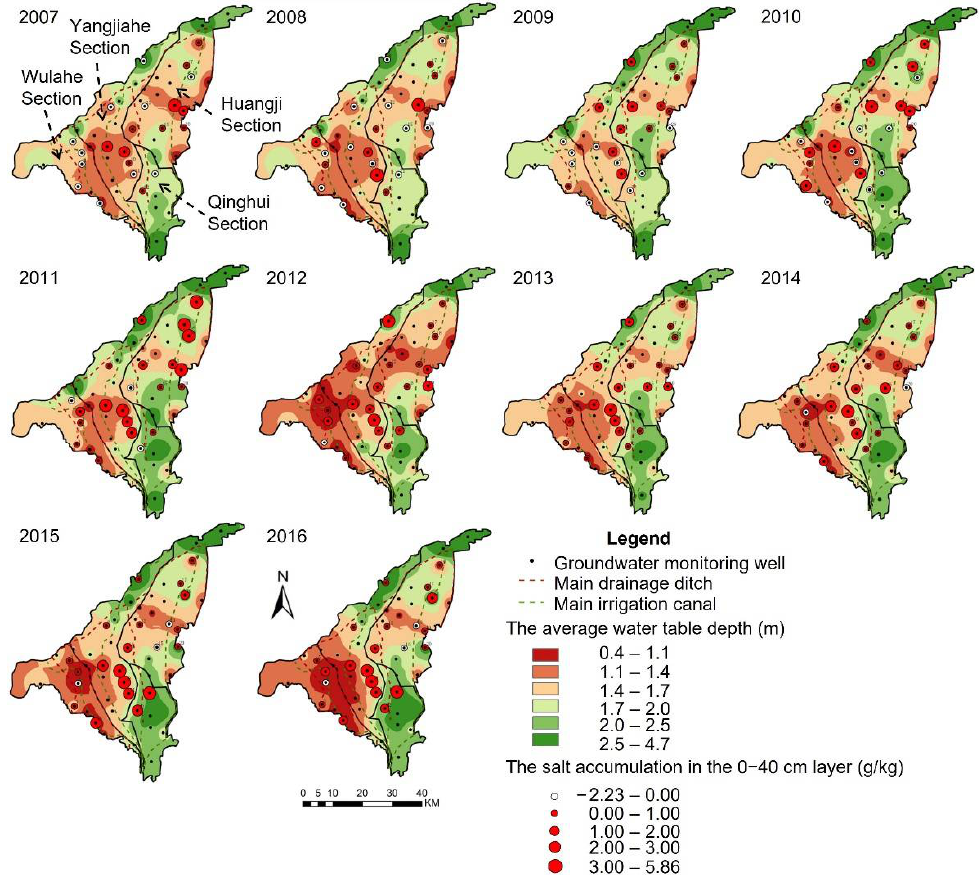
Figure 5. The variation of the cropping season salt accumulation in the 0–40 cm layer of the 22 soil sampling sites and the cropping season water table depth in the Jiefangzha Subdistrict (JFZSD) from 2007 to 2016.